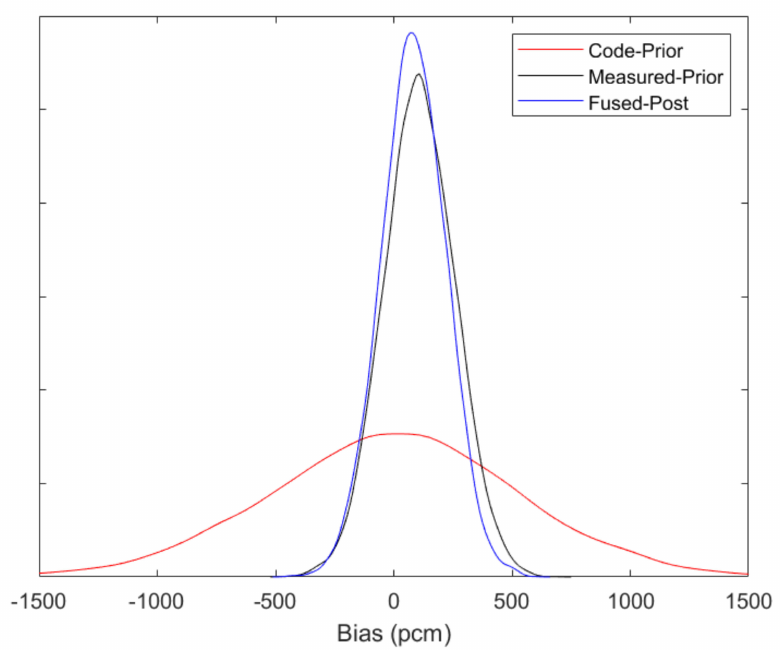
Figure 4. Prior and consolidated PDFs for the representative experimental